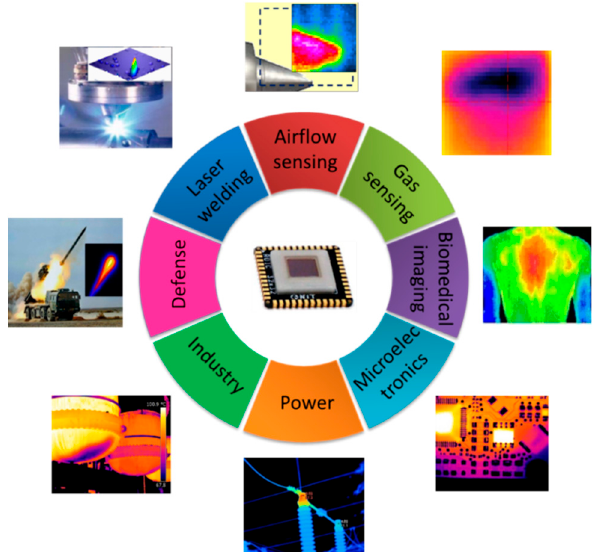
Figure 1. Various potential applications for uncooled photodetector with lead selenide (PbSe) polycrystalline coating in mid-infrared range. Reprinted with permission from [49]. Copyright SPIE 2013.